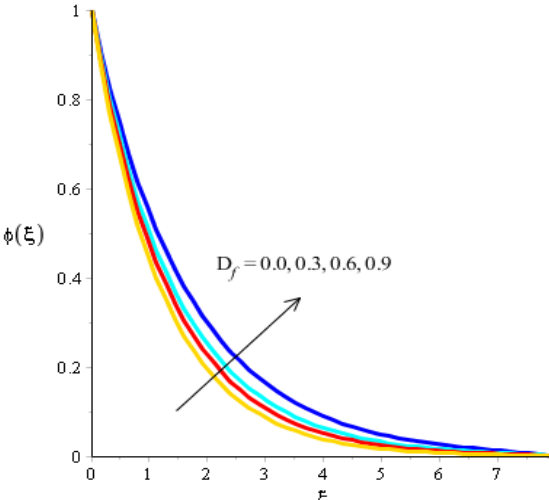
Figure 11. Analysis of concentration curves versus D f .